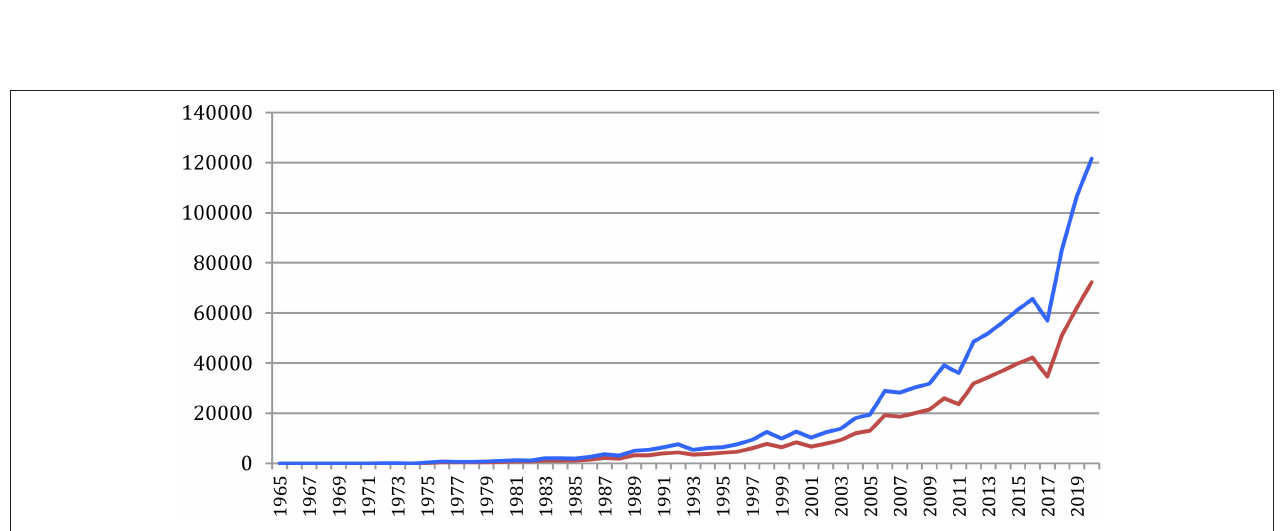
FIGURE 26 | Total number of references (blue) and of NLP4NLP references (red) in NLP4NLP papers yearly.